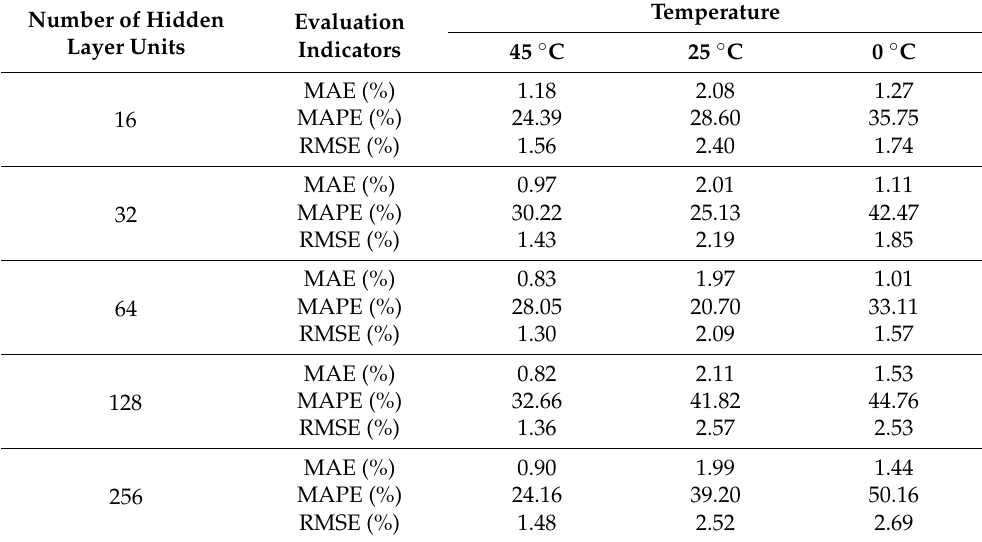
Table 2. Comparison of results for different numbers of hidden layer